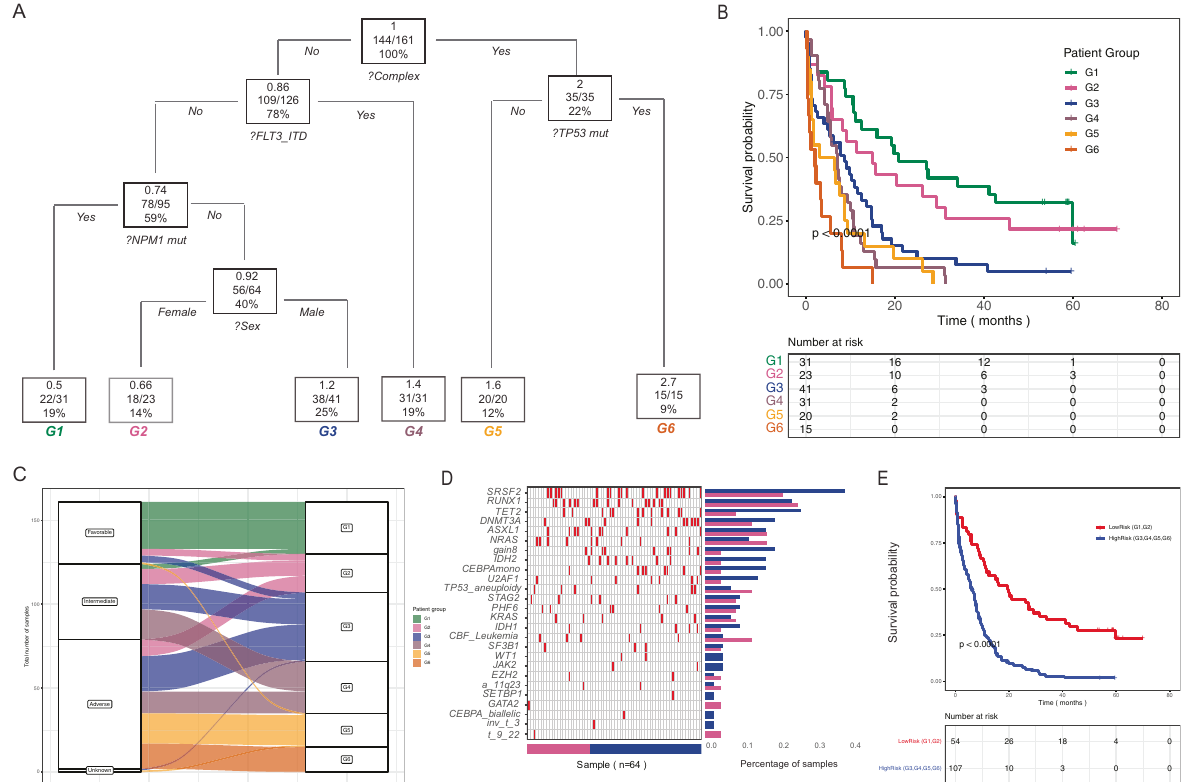
Fig. 2 Integrative classi fi er identi fi es sex-associated outcomes. A Decision tree from the recursive partitioning analysis identi fi ed six distinct prognostic subgroups (G1 – G6). Molecular characteristics of the group are de fi ned as: G1 - Patients with non complex cytogenetics lacking FLT3-ITD mutations with mutations identi fi ed in NPM1 ; G2 - Female patients with non complex cytogenetics lacking FLT3-ITD and NPM1 mutations; G3 - Male patients with non complex cytogenetics lacking FLT3-ITD mutations and NPM1 mutations; G4 - Patients with non complex cytogenetics and FLT3-ITD mutations; G5 - Patients with complex cytogenetics and lacking TP53 mutations; G6 - Patients with complex cytogenetics and mutations in TP53 . Top number in each box is the hazard ratio, the middle ratio is the number of deaths/total number of patients in the tree branch considered, and the bottom number is the percent of the total number of patients in each tree branch. B Kaplan – Meier curves representing the survival probabilities in each of the six prognostic groups in the study cohort. The p -value was calculated using the log-rank test. C Proportional distributions of ELN categories (1 = favorable, 2 = intermediate, 3 = adverse, 4 = unknown) in the six prognostic subgroups (G1 – G6). D Comparison of the frequencies of somatic mutations and cytogenetic events between the G2 and G3 prognostic groups. The plot on the left is a heatmap of the mutations in each gene per patient (red: mutated; white: wild type). The bar plot shows the percentage of samples with mutations in the gene of interest. E Kaplan – Meier curves comparing high (G3 – G6) and low (G1, G2) risk groups in the study cohort. P -values were calculated using log-rank